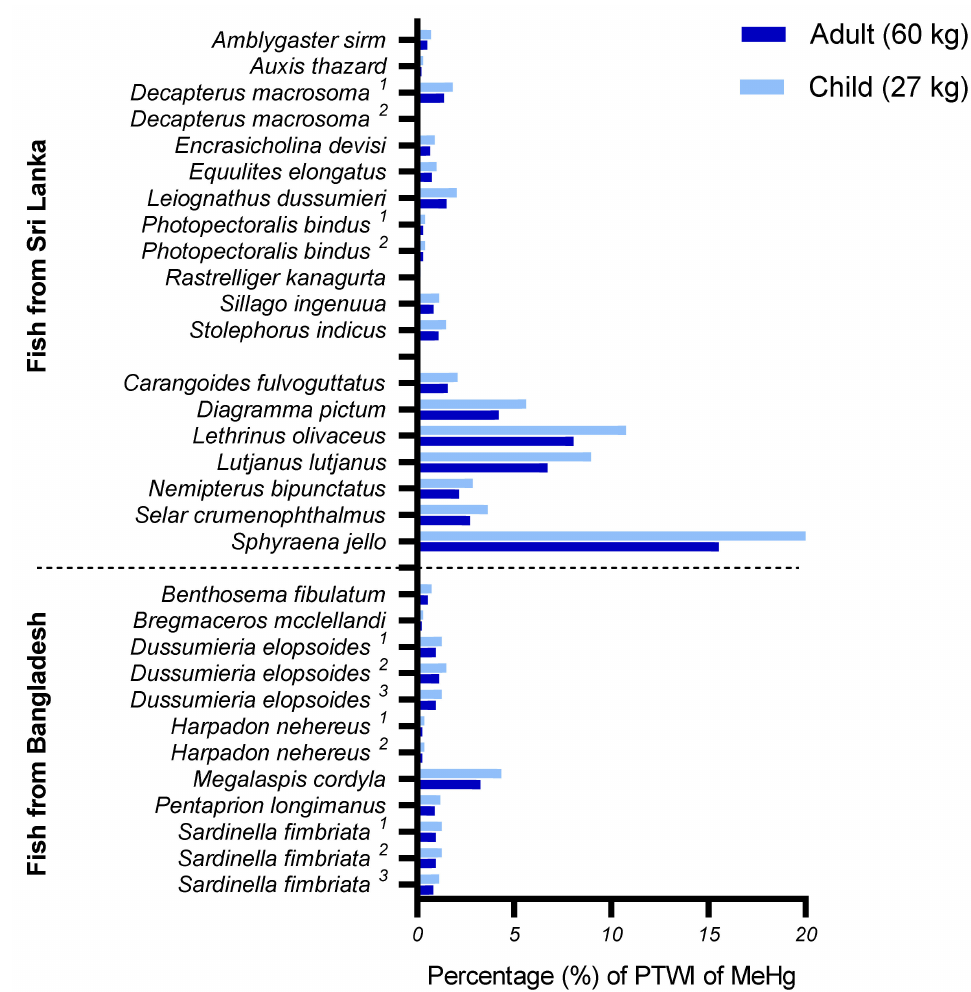
Figure 1. Potential consumer exposure for adults and children to methylmercury (MeHg), expressed as the metal content in one portion (43 and 26 g for Sri Lankan adults and children, respectively, and 54 and 32 g for Bangladeshi adults and children, respectively) of the various fish species from Sri Lanka and Bangladesh compared to the provisional weekly intake (PTWI) set by the JECFA. 1,2,3 Fish species sampled multiple times at separate